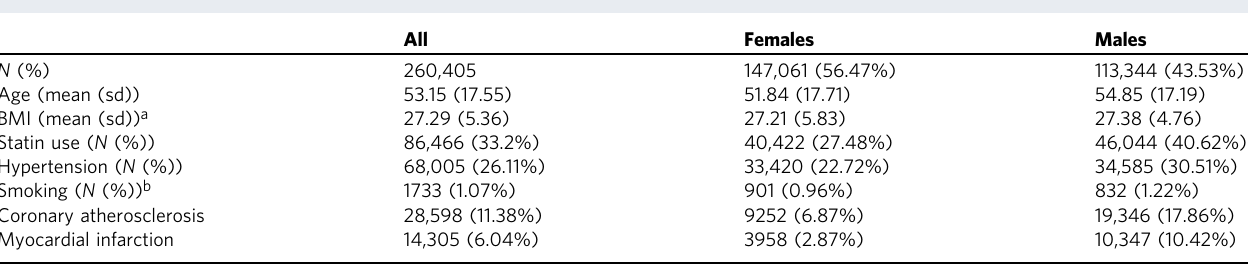
Table 3 Basic characteristics of the study